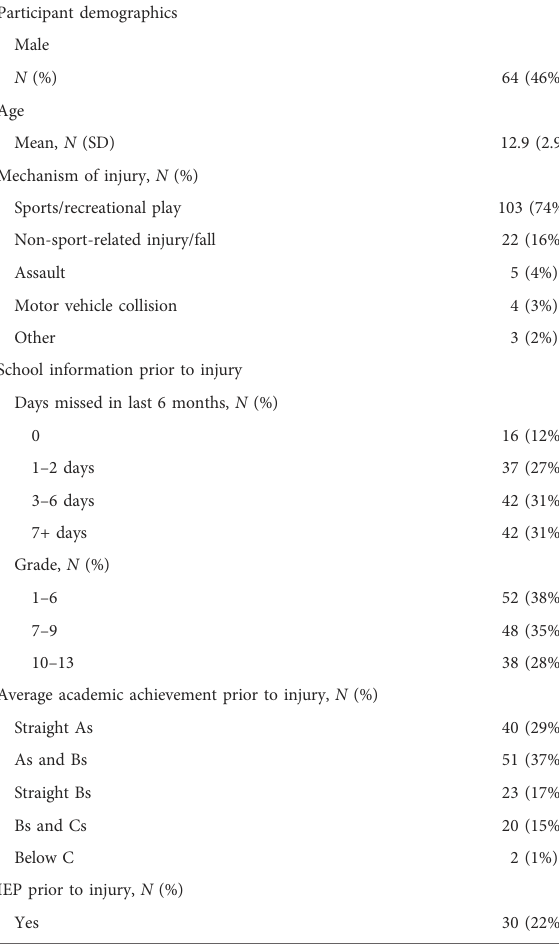
TABLE 2 Participant demographics ( N